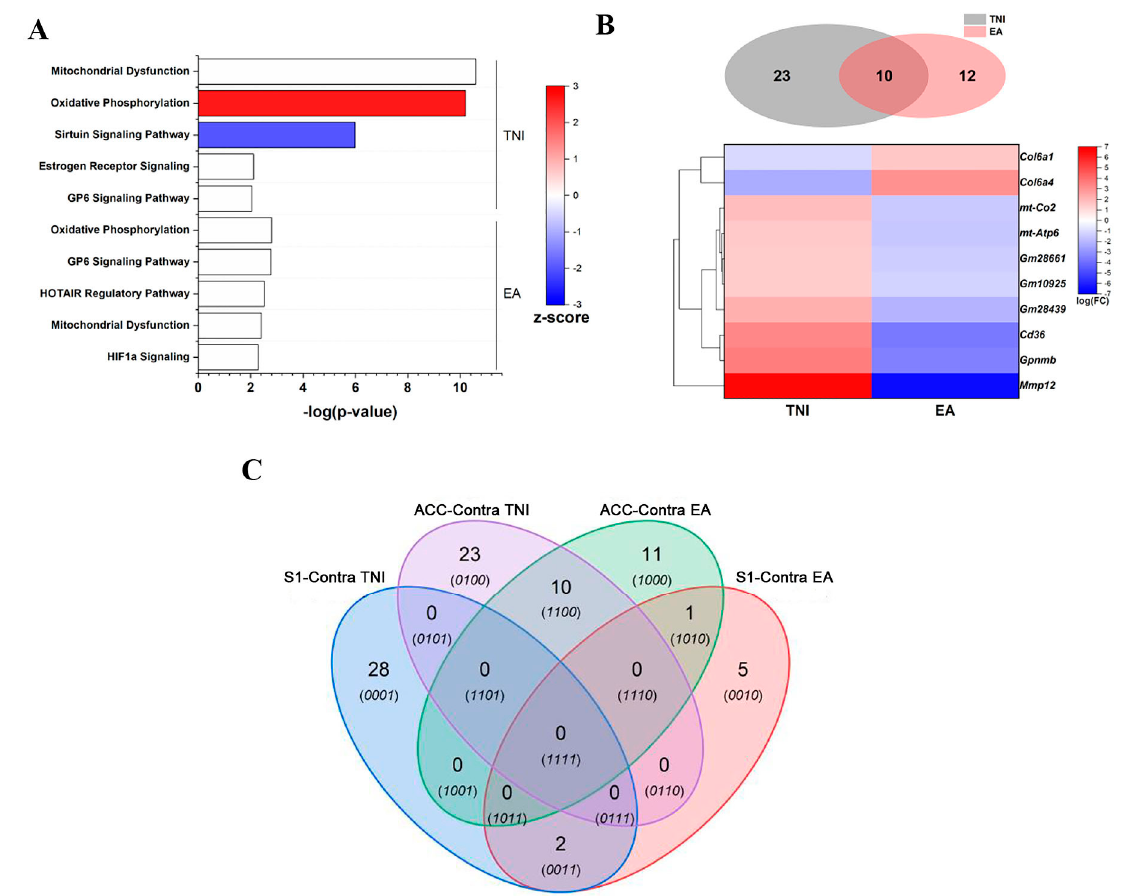
Figure 4. Brain region: ACC (contralateral). ( A ) Top 5 canonical pathways identified based on DEGs of TNI and sham groups and electroacupuncture − treated − TNI and TNI groups. Venn diagrams of DEGs arising from TNI and EA are summarized in ( B ) ( top ) with an expression map for common genes ( bottom ) for the ACC contralateral region. ( C ) Venn diagram showing similarity of DEGs among di ff erent treatment groups in the contralateral ACC and S1. N = 4.